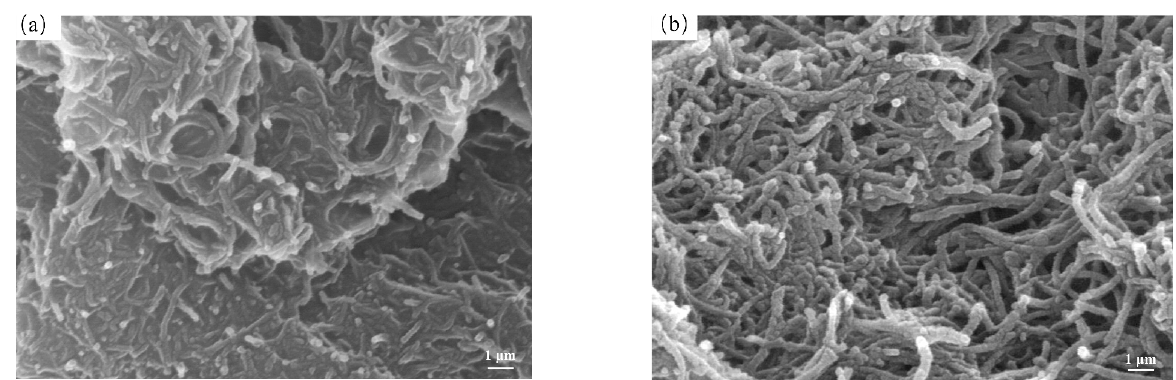
Figure 3. SEM images of ( a ) CNTs and ( b ) CNTs@PDA.